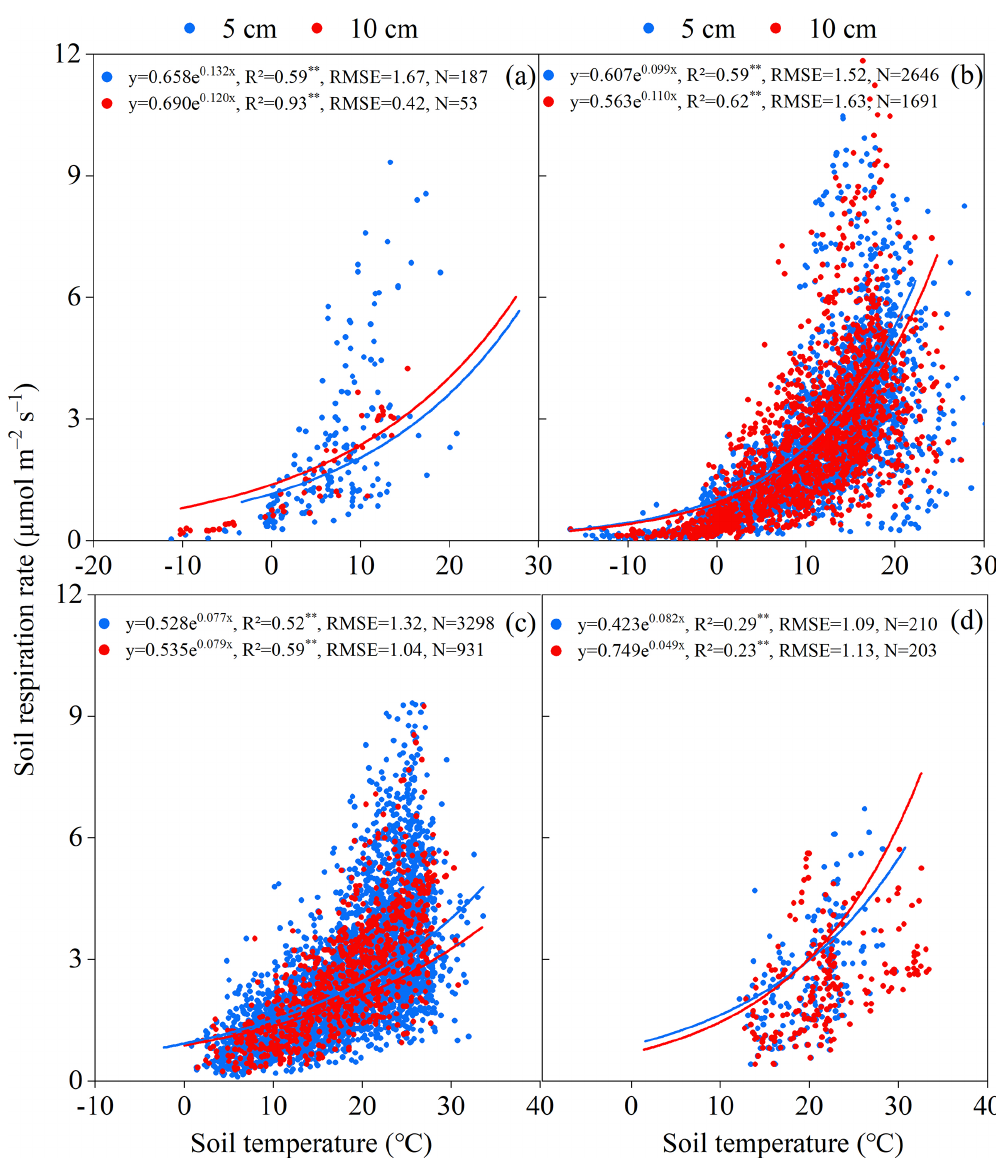
Figure 2. Exponential relationships of forest soil respiration rates with soil temperature at 5 and 10cm depth in cold-temperate (a) , temper- ate (b) , subtropical (c) , and tropical zones (d) . ∗∗ P < 0 .